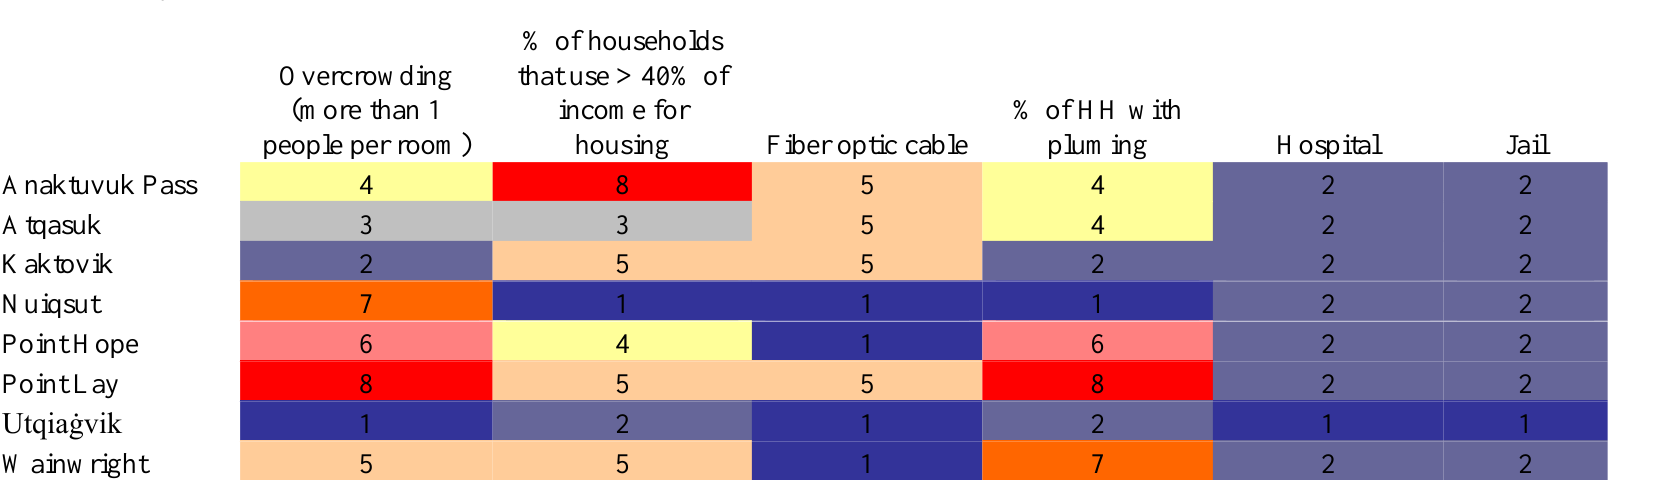
Table A2.6 Physical infrastructure – rank